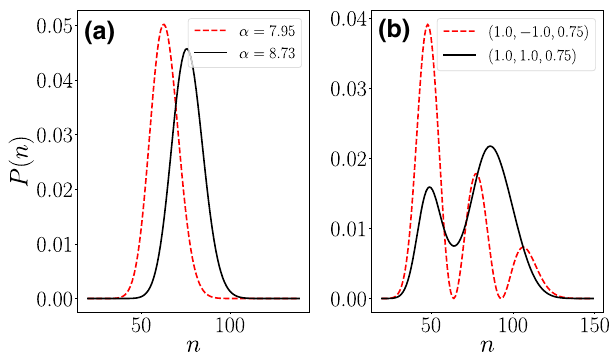
FIG. 2. Photon-number probability distributions for (a) two coherent states with α = 7.95 (red dashed curve) and α = 8.73 (black solid curve), and (b) a superposition of three coherent states of the form | φ (cid:2) = a 1 | 7 (cid:2) + a 2 | 9 (cid:2) + a 3 | 10 (cid:2) with ( a 1 , a 2 , a 3 ) = ( 1.0, − 1.0, 0.75 ) (red dashed curve) and ) = ( 1.0, 1.0, 0.75 ) (black solid curve). The coefficients ( a 1 , a 2 , a 3 in the superposition are shown up to a normalization that, nonetheless, has been taken into account when doing the plots. In both plots, the mean photon number is (cid:10) n (cid:2) ≈ 63.2 for the red dashed curve probability distribution and (cid:10) n (cid:2) ≈ 76.2 for the black solid